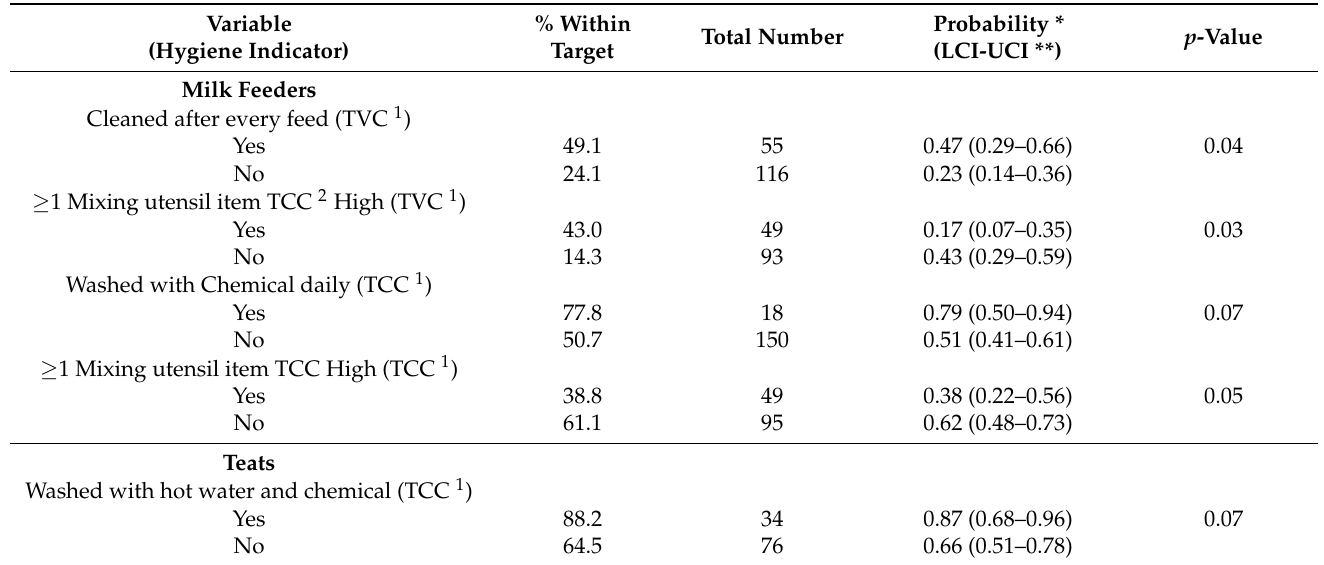
Table 4. Sample source and farm housing and management factors for milk feeding equipment that impacted likelihood of meeting hygiene indicator